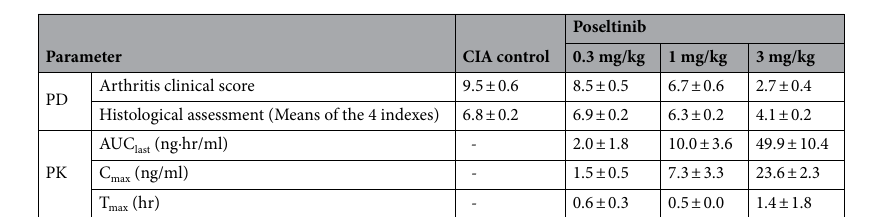
Table 1. PK/PD and efficacy relationship in CIA model of rat. In vivo PK/PD profiles on day 8 (PD) and 9 (PK) after consecutive daily oral administration of poseltinib to CIA model of rats. Data are presented as the mean ± SEM (PD) and mean ± SD (PK). Summary of PK/PD profiles of poseltinib in rats CIA model after consecutive daily oral administration. Blood was collected from the treated CIA model rats for PK analysis on day 9 and for PD analysis on day